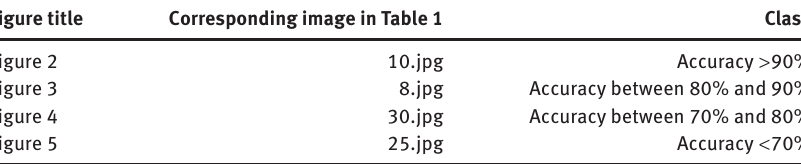
Table 3. Example Images and their Corresponding Classes. Corresponding image in Table 1 Class Figure 2 10.jpg Accuracy > 90% Figure 3 8.jpg Accuracy between 80% and 90% Figure 4 30.jpg Accuracy between 70% and 80% Figure 5 25.jpg Accuracy <